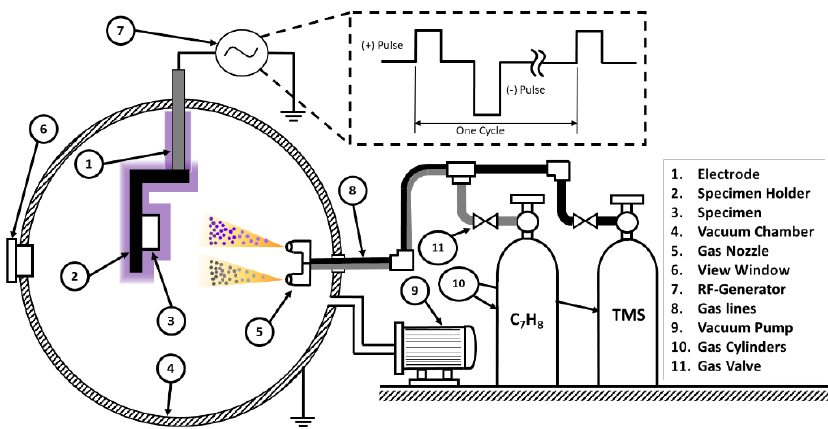
Figure 1. Schematic diagram of Bipolar PBII&D (Color does not needed to be used).